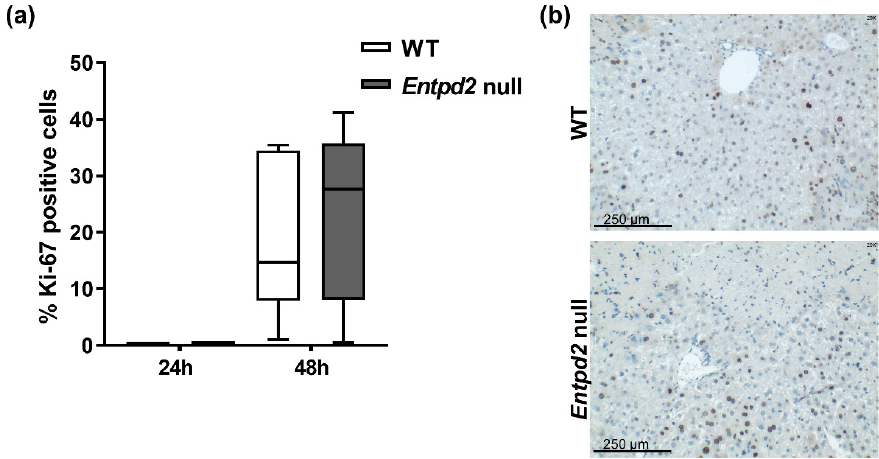
Figure 3. NTPDase2 deficiency does not impair liver cell proliferation after APAP intoxication. ( a ) Proliferation rate as percentage of Ki-67 positive cells out of all nucleated cells. ( b ) Representative images of Ki-67 staining in WT vs Entpd2 null livers (200 × ), n ≥ 6 per genotype and time